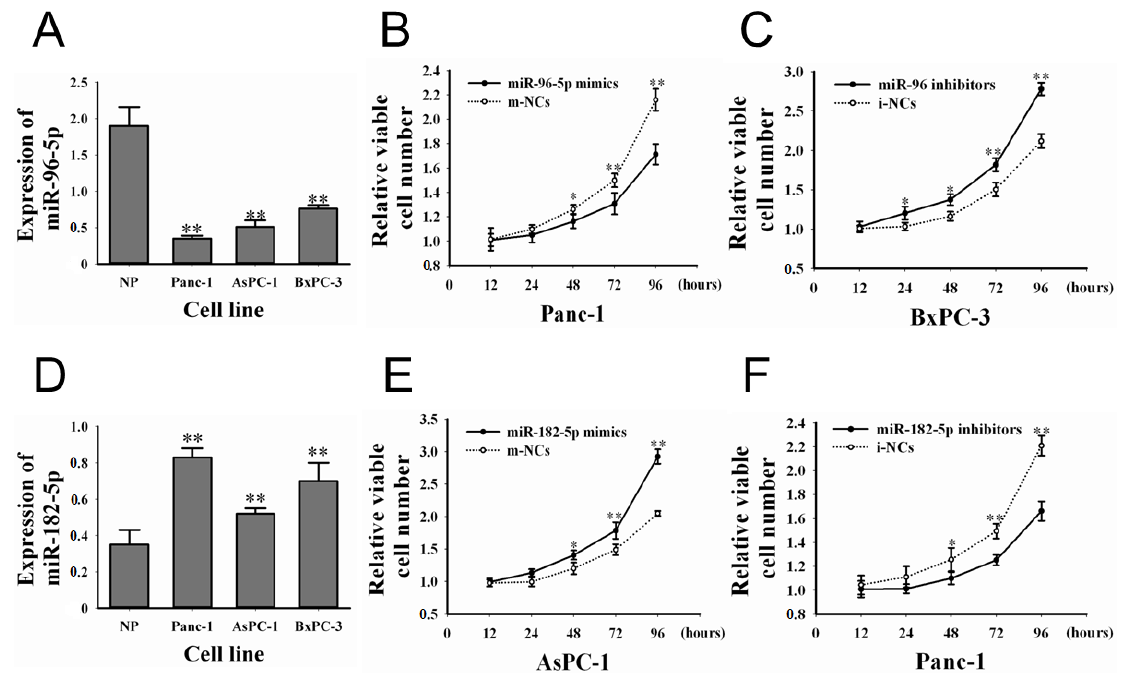
Figure 2. The expression of miR-96-5p and -182-5p in cell lines and their effects on PC cell proliferation. ( A ) The expression level of miR-96-5p in three pancreatic cancer cell lines (Panc-1, AsPC-1, and BxPC-3) and normal pancreatic tissues; ( B ) Upregulation of miR-96-5p inhibited proliferation in Panc-1; ( C ) Downregulation of miR-96-5p promoted proliferation in BxPC-3; ( D ) The expression level of miR-182-5p in three pancreatic cancer cell lines (Panc-1, AsPC-1, and BxPC-3) and normal pancreatic tissues; ( E ) Upregulation of miR-182-5p promoted proliferation in AsPC-1; ( F ) Downregulation of miR-182-5p inhibited proliferation in Panc-1. All data from three separate experiments are presented as mean ± SD. * p < 0.05; ** p <